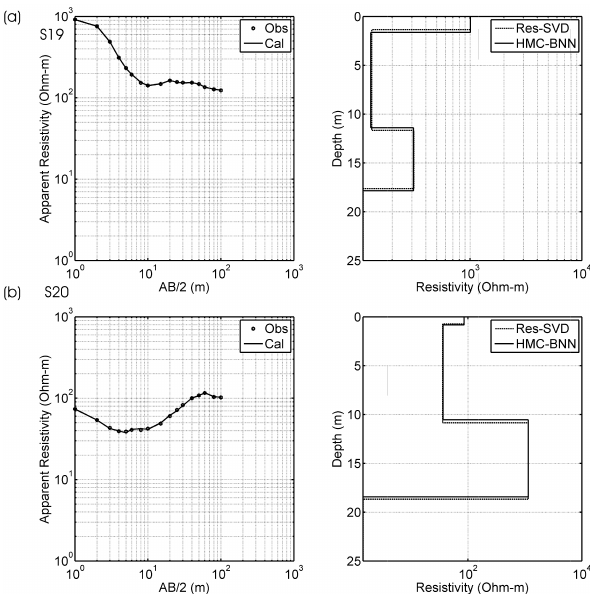
Fig. 6. The comparison of Hybrid Monte Carlo (HMC)-based Bayesian neural network (BNN) inversion results with singular value decomposition (SVD)-based conventional resistivity inver- sion results for soundings (a) s19 and (b) s20.